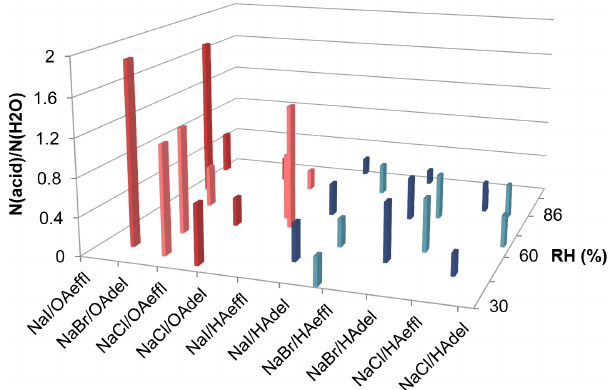
Figure 8. N HA / N H and N OA / N H mole ratios in heteroge- 2 O 2 O neously coated particles at various relative humidities in deliques- cence and efflorescence conditions. “del” and “effl” stand for deli- quescence and efflorescence. “RH” stands for relative